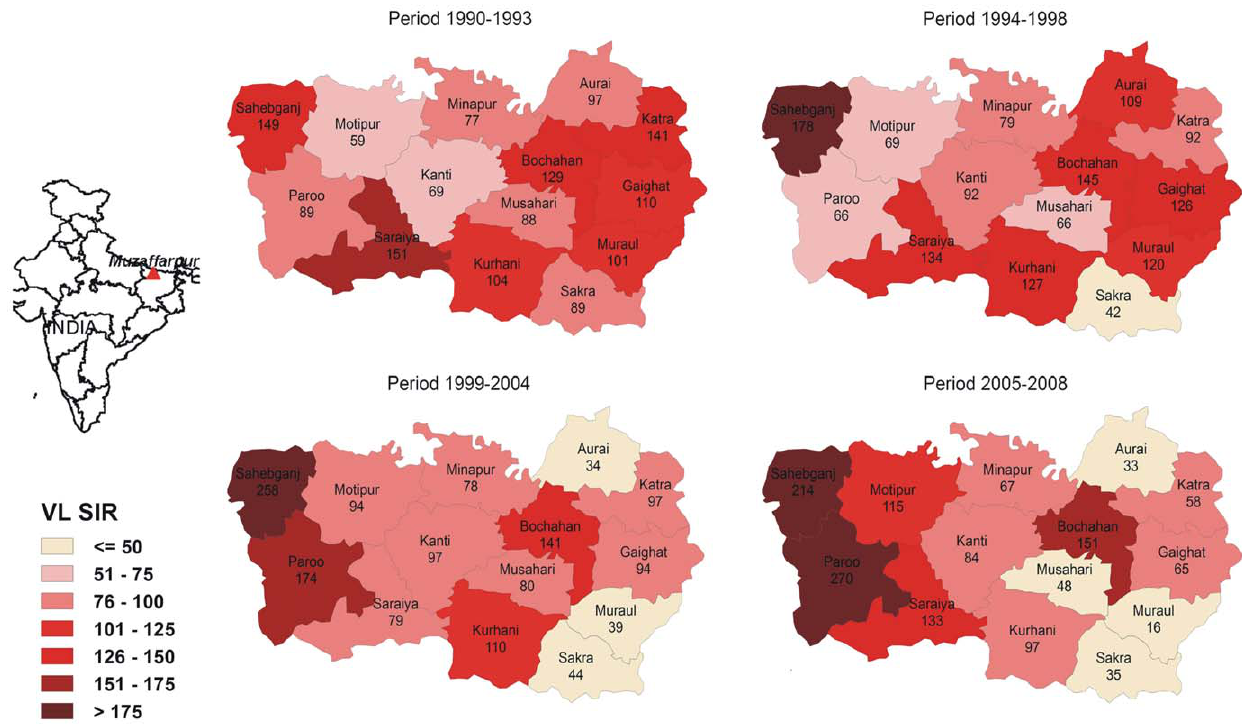
Figure 4. Visceral Leishmaniasis (VL) Standardised Incidence Ratio (SIR) per block in Muzaffarpur district in Bihar, India. VL SIR computed for the following periods: 1990–1993, 1994–1998, 1999–2004 and 2005–2008 using the VL incidence per period in all blocks as reference.